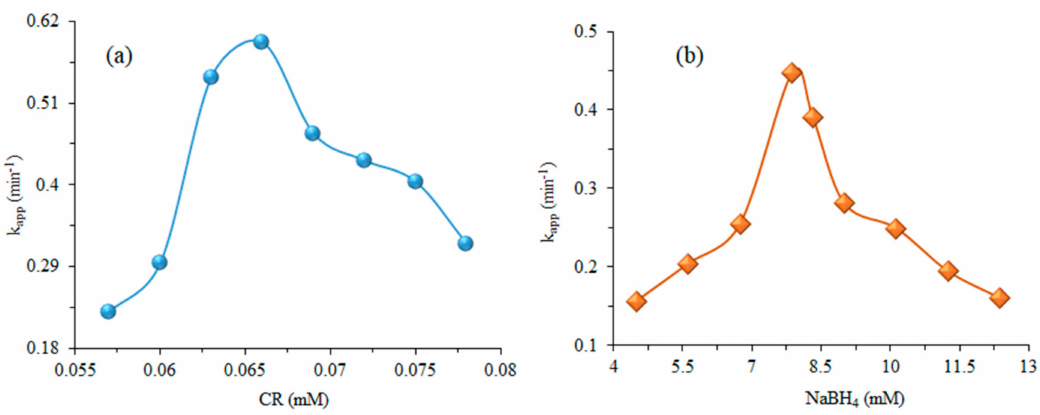
Figure 9. ( a ) CR concentration, ( b ) Sodium borohydride concentration dependent k app relation for degradation of CR at ambient temperature (Reaction conditions: [NaBH 4 ] = 7.88 mM, [CR] = 0.072 mM and catalyst = 2.1 mg / mL).